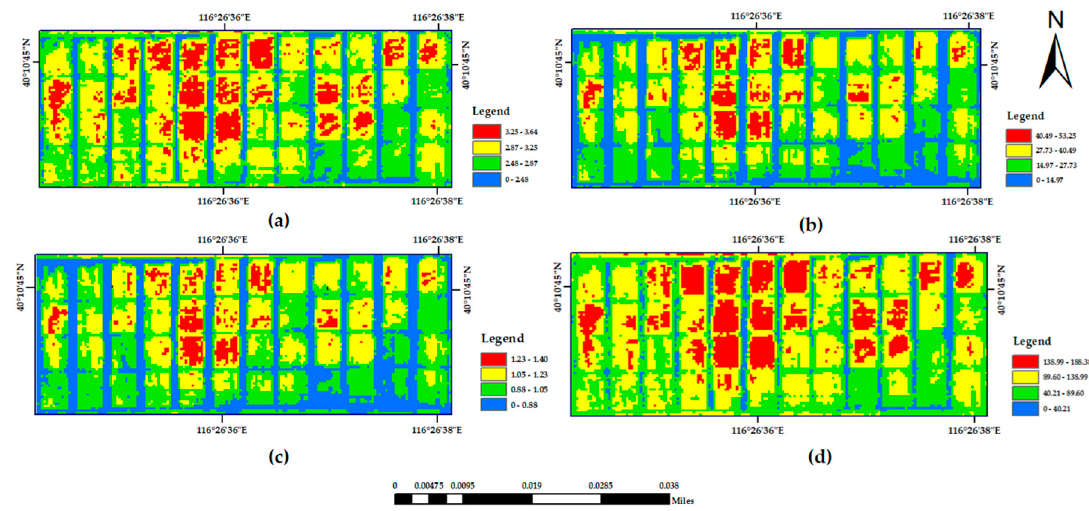
Figure 9. UAV data inversion map of four nitrogen nutrition parameters. ( a ) LNC spatial distribution map. ( b ) LNA spatial distribution map. ( c ) PNC spatial distribution map. ( d ) PNA spatial distribution map.